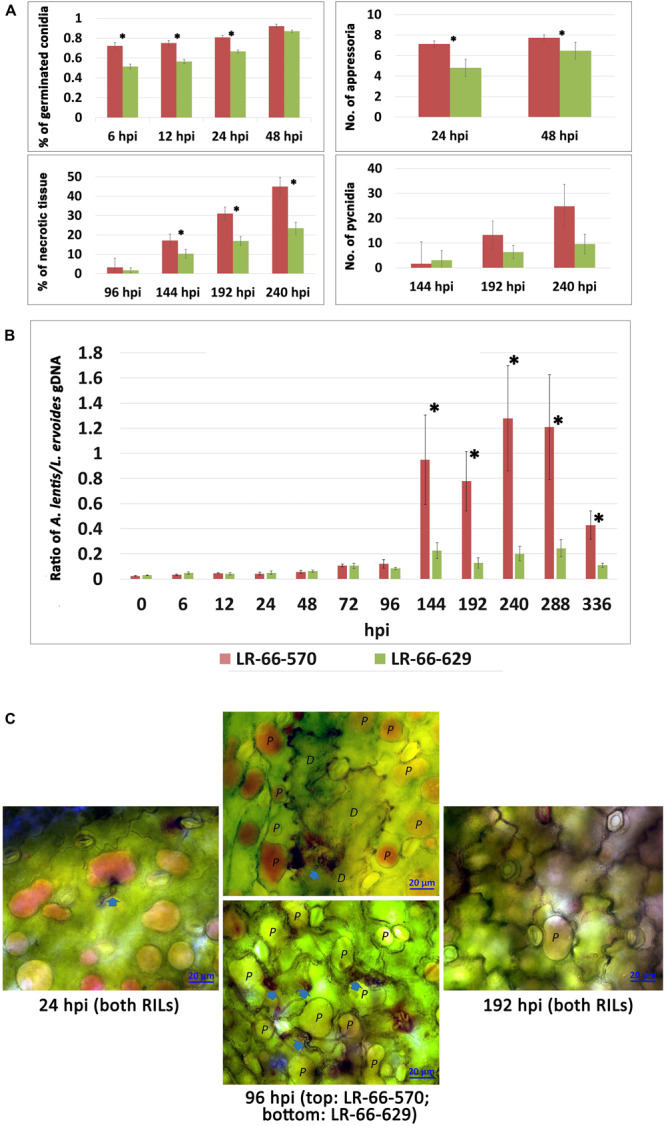
Quantitative assessment of Ascochyta lentis progression in susceptible Lens ervoides RILs LR-66-570 and resistant LR-66-629. (A) Histopathological assessment of four A. lentis developmental parameters in two RILs from 6 to 240 h post inoculation (hpi). (B) qPCR quantification of relative A. lentis biomass in the two RILs from 0 to 336 hpi. The A. lentis biomass was determined as the gDNA ratio between A. lentis (estimated based on β-tubulin) and L. ervoides (estimated based on elongation factor 1α). Asterisks indicate significant differences between means at P < 0.05. Error bars represent standard errors of the means. (C) Changes in viability of epidermal cells at 24, 96 and 192 hpi with A. lentis. Photos reflected the most prevalent events in RILs. Viable cells (labelled as P) show accumulation of the dye in the vacuole only whereas dead cells (labelled as D) are stained throughout.